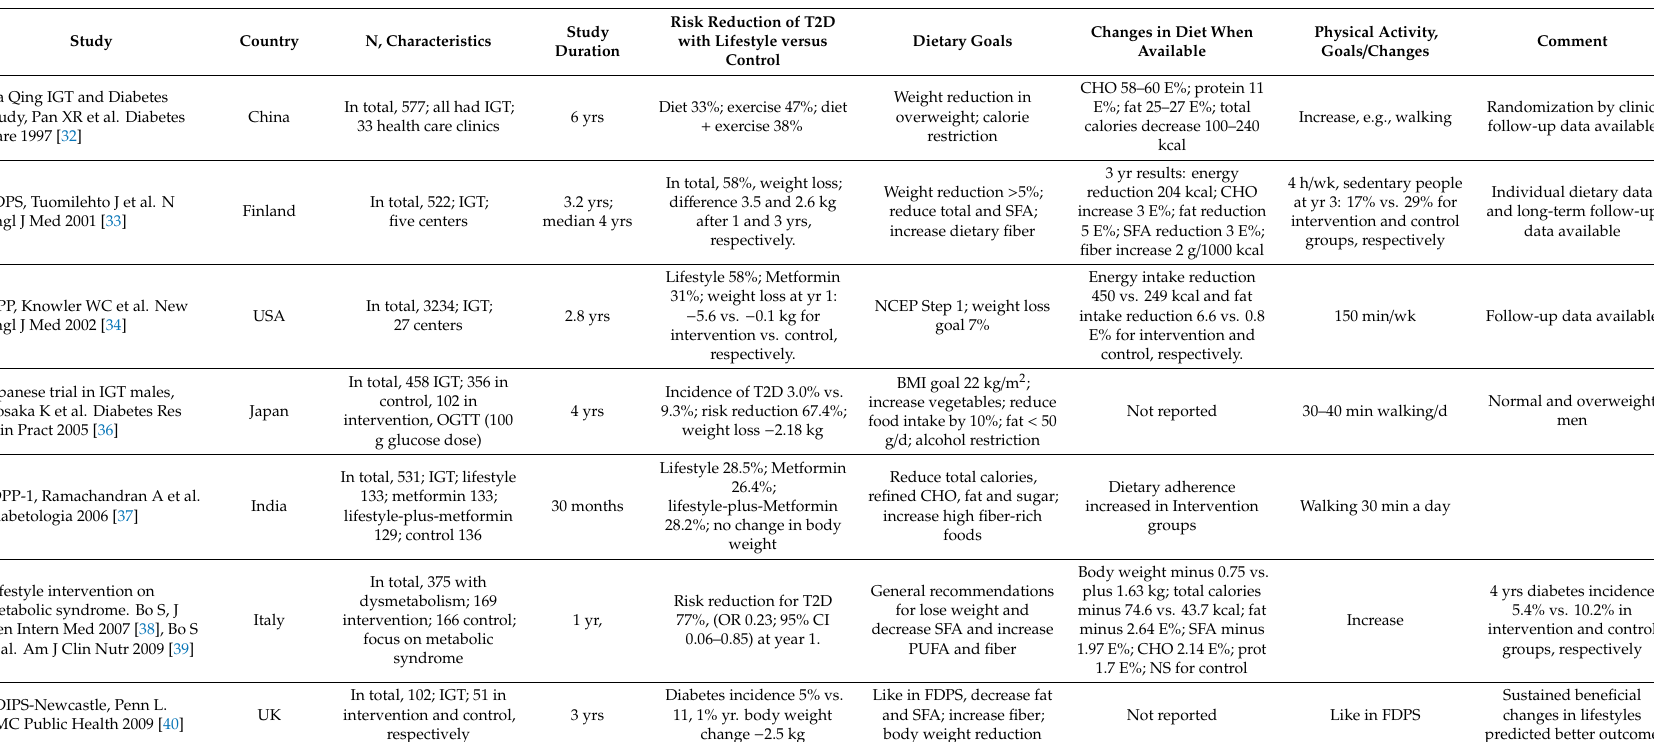
Table 1. Summary results on the randomized controlled trials aimed to prevent type 2 diabetes in people with impaired glucose tolerance or in people at high increased risk for